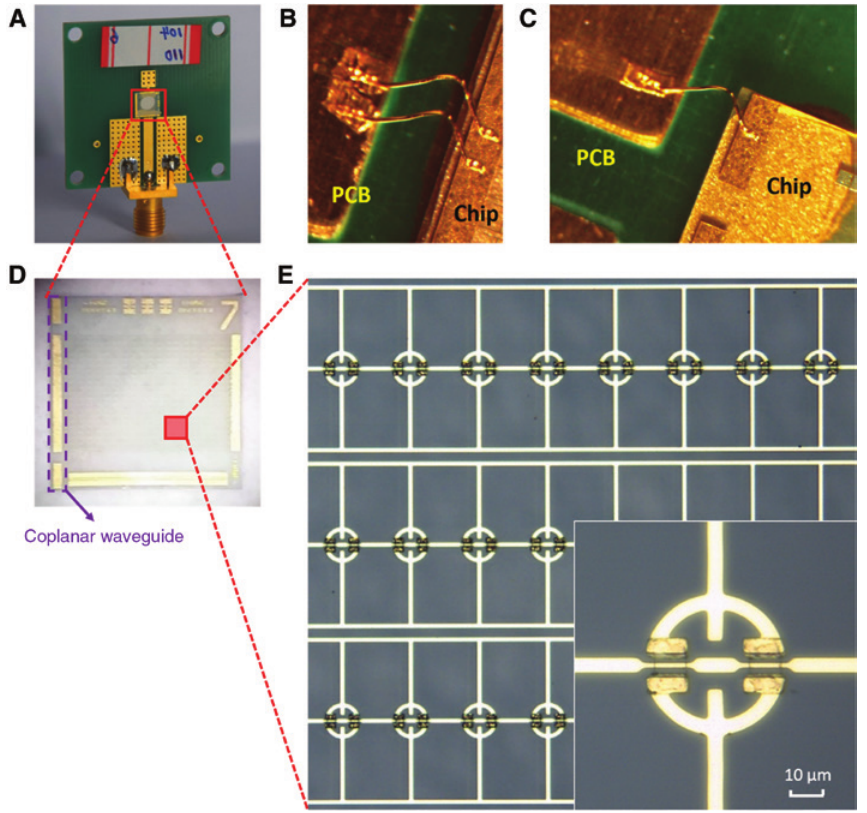
Figure 3: Manufactured sample: (A) image of a packaged phase modulator, (B and C) gold bonding wires connecting the CPWs (PCB and chip), (D) image of the chip, and (E) photomicrograph of a portion of the fabricated